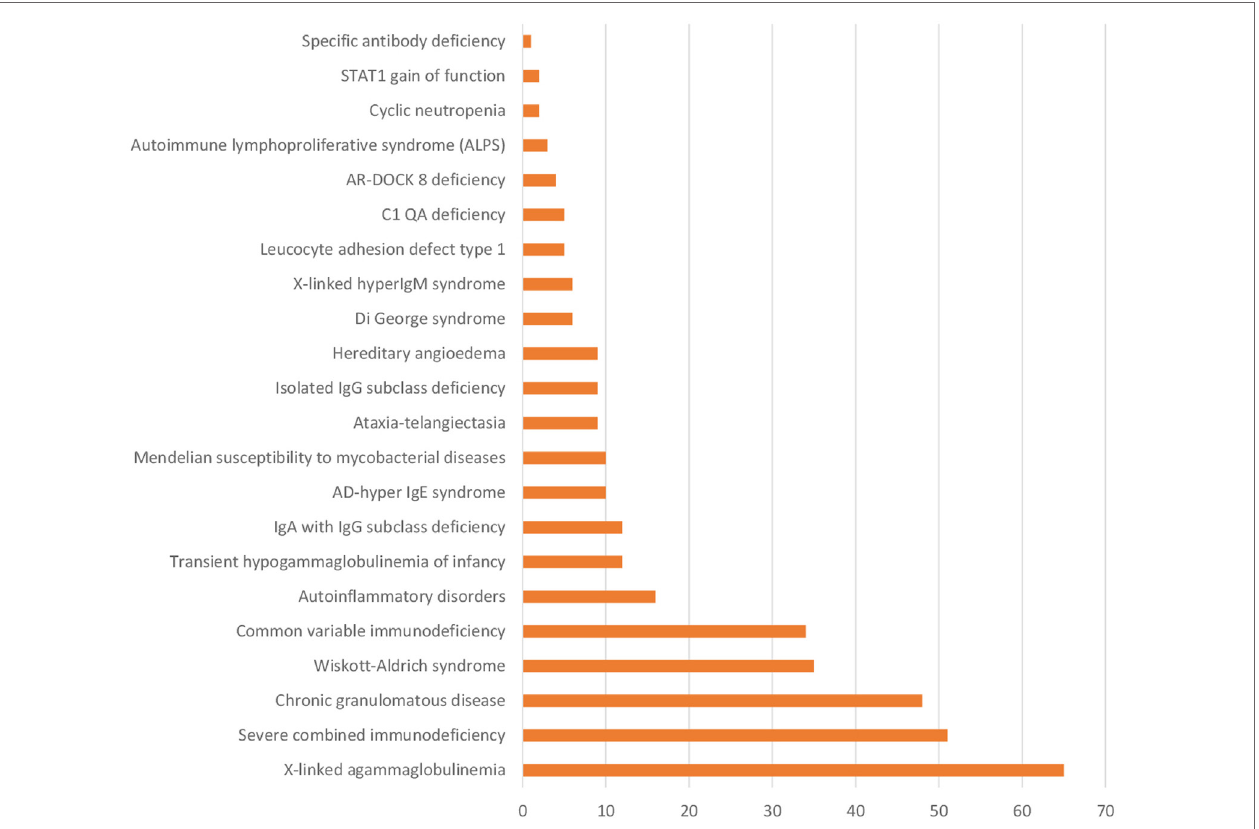
FigUre 2 | Number of patients with various PIDs at Postgraduate Institute of Medical Education and Research, Chandigarh (January 1990–March 2017).